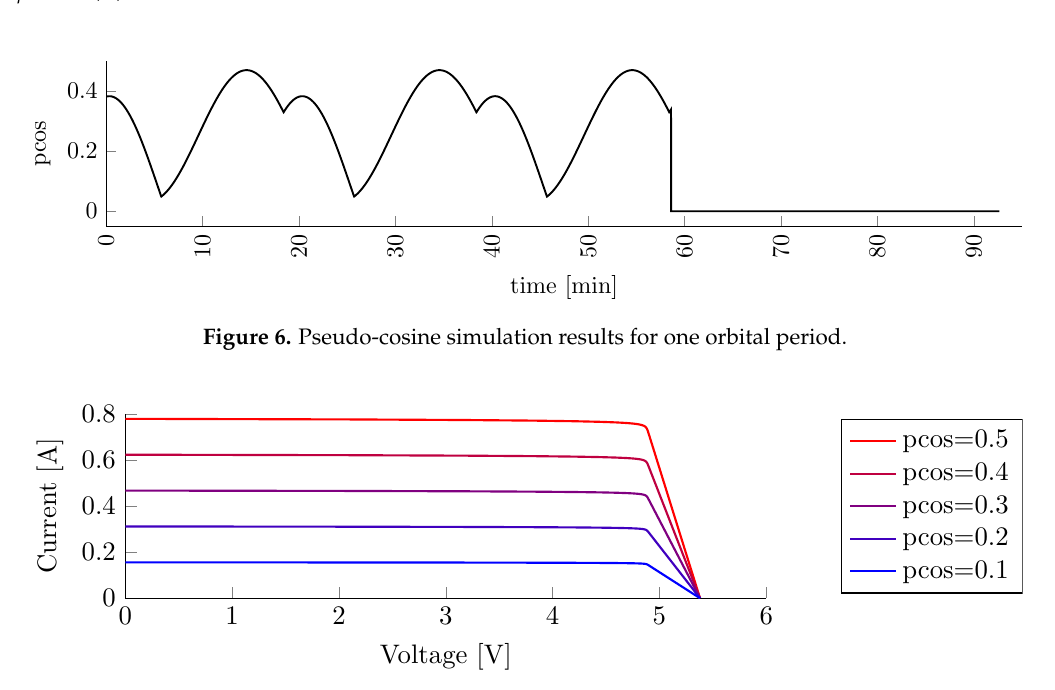
Figure 7. Relation between the pseudo-cosine and the IV curve of the SAS.